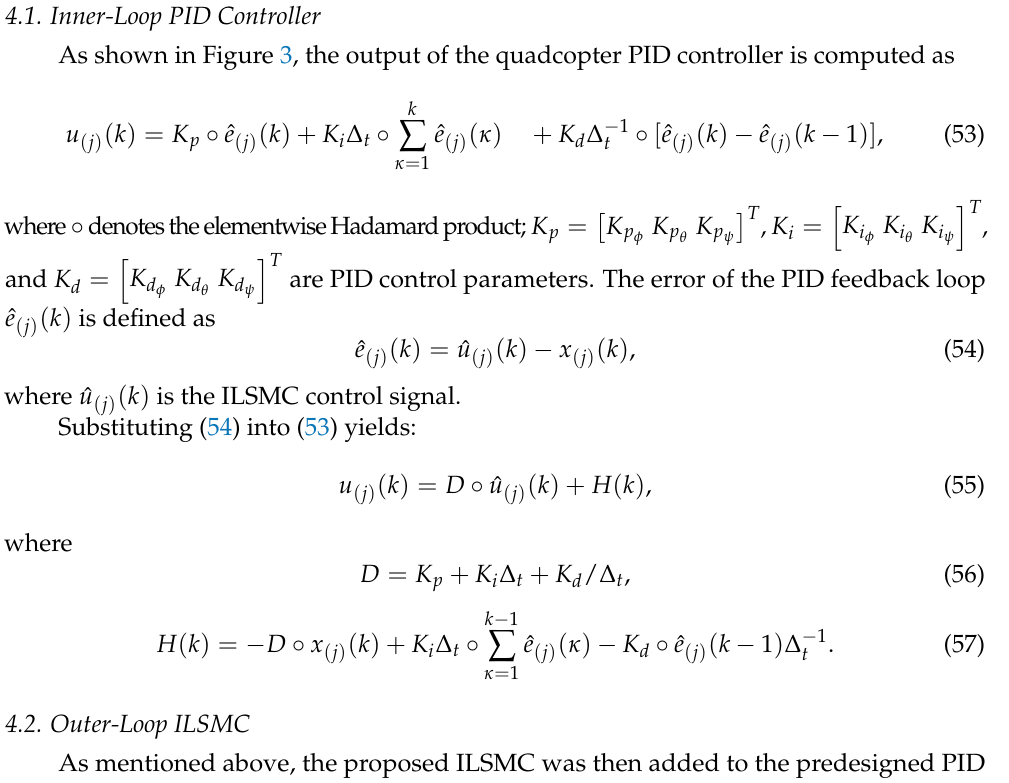
Figure 3. ILSMC in a cascade PID-controlled